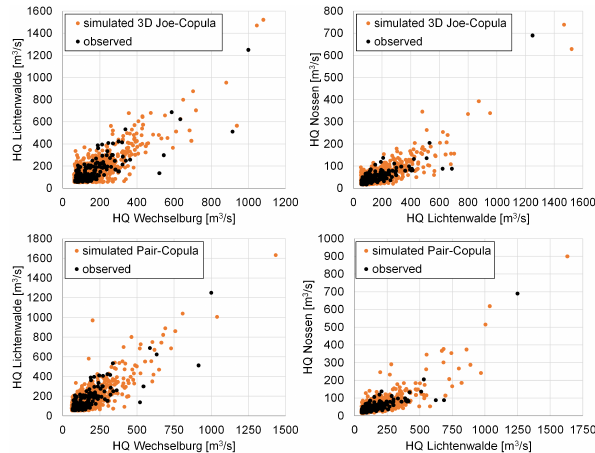
Figure 3. Randomized trivariate samples of 1000 elements over- layed with the observed simultaneous peak values, 1st row: trivari- ate Joe-Copula, 2nd row: Pair-Copula (HQ stands for peak dis-